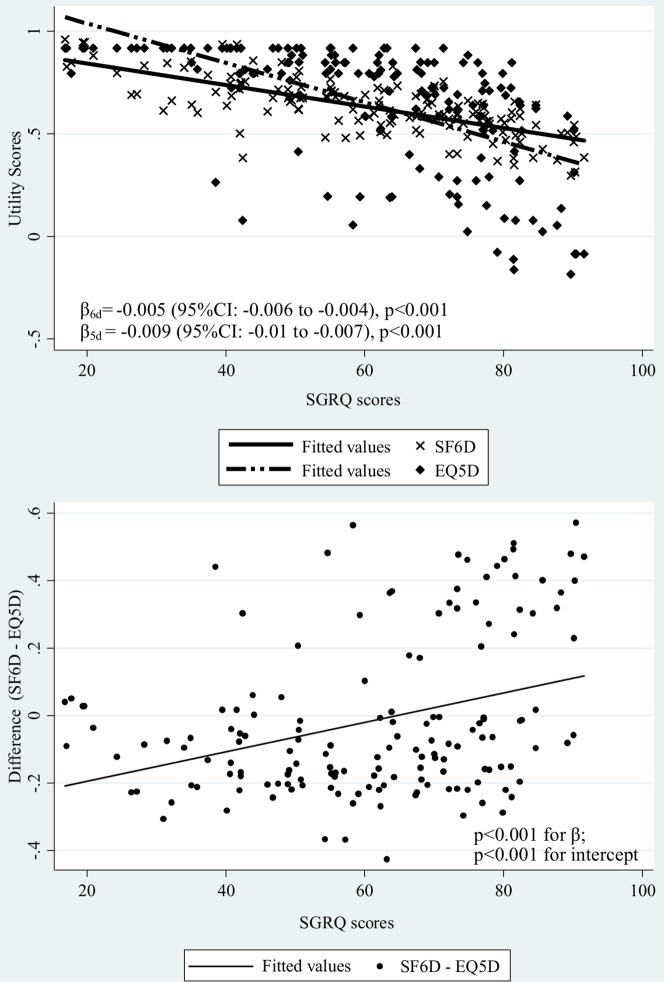
Scatter plots of SF-6D vs. SGRQ, EQ-5D vs. SGRQ (above) and difference (SF-6D – EQ-5D) vs. SGRQ (below).